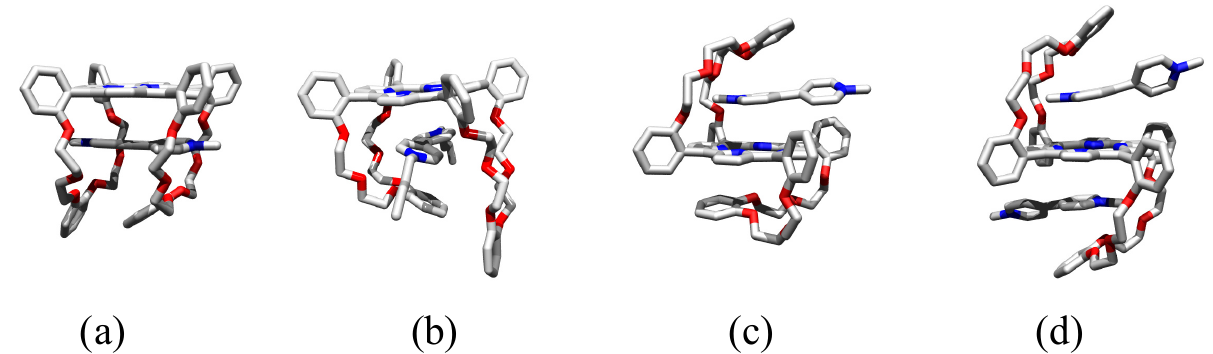
Figure 5. Molecular models, based on the binding studies, of the 1:1 complexes between ( a ) C and V1 , ( b ) C and V2 (blocking groups are not shown for clarity), ( c ) S and V1 and ( d ) the 1:2 complex between S and V1